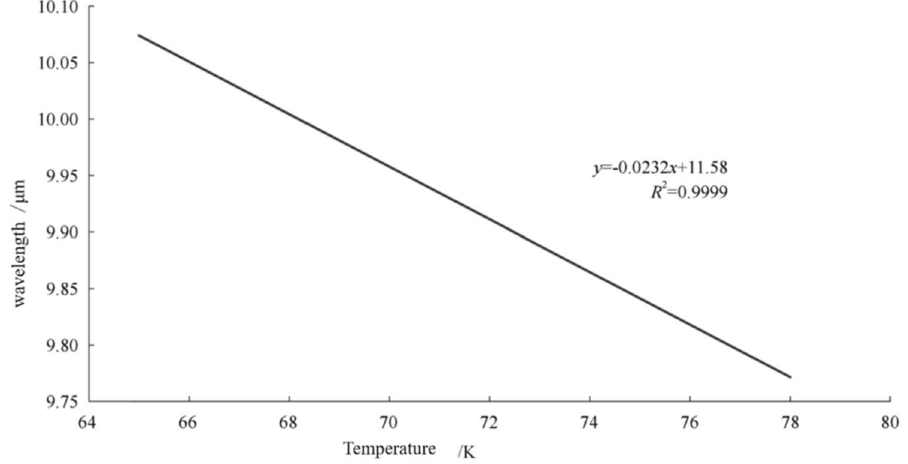
Figure 3. Relationship of wavelength and temperature of mercury cadmium telluride detector 7